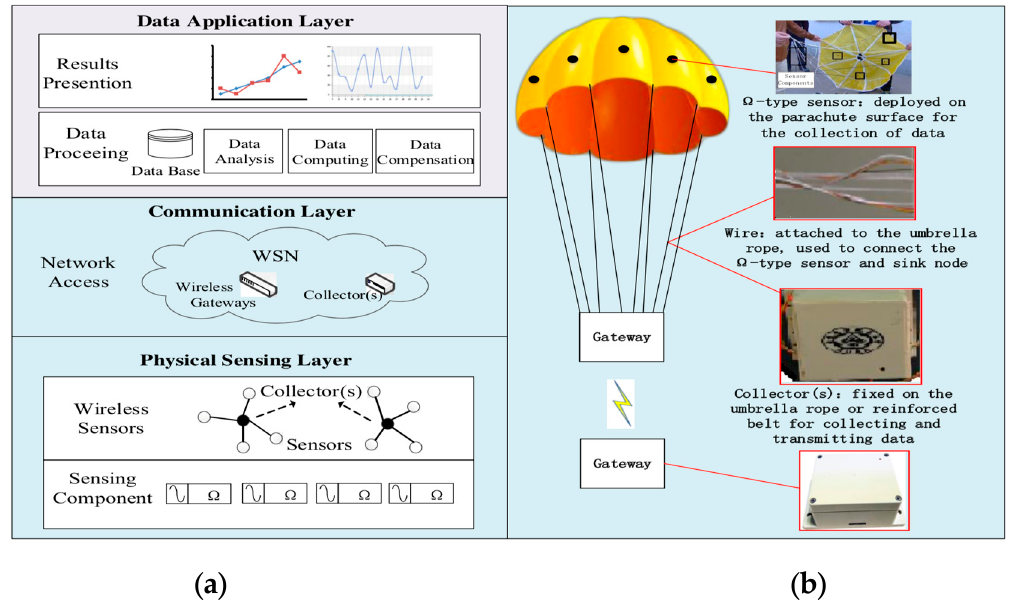
Figure 1. Structure of dynamic measurement system based on airdropped WSN. ( a ) Overall system structure. ( b ) Deployment detail on a parachute.